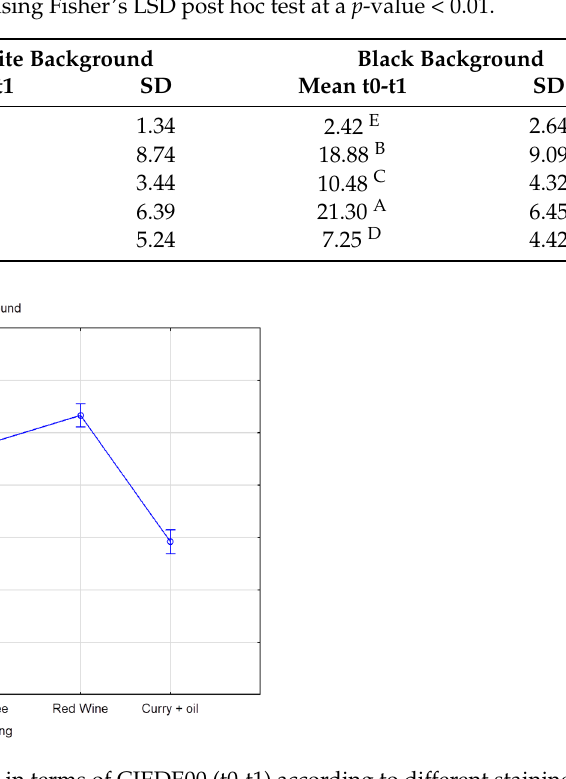
Figure 5. L*a*b* change over time for every bleaching agent over a black and a white background.